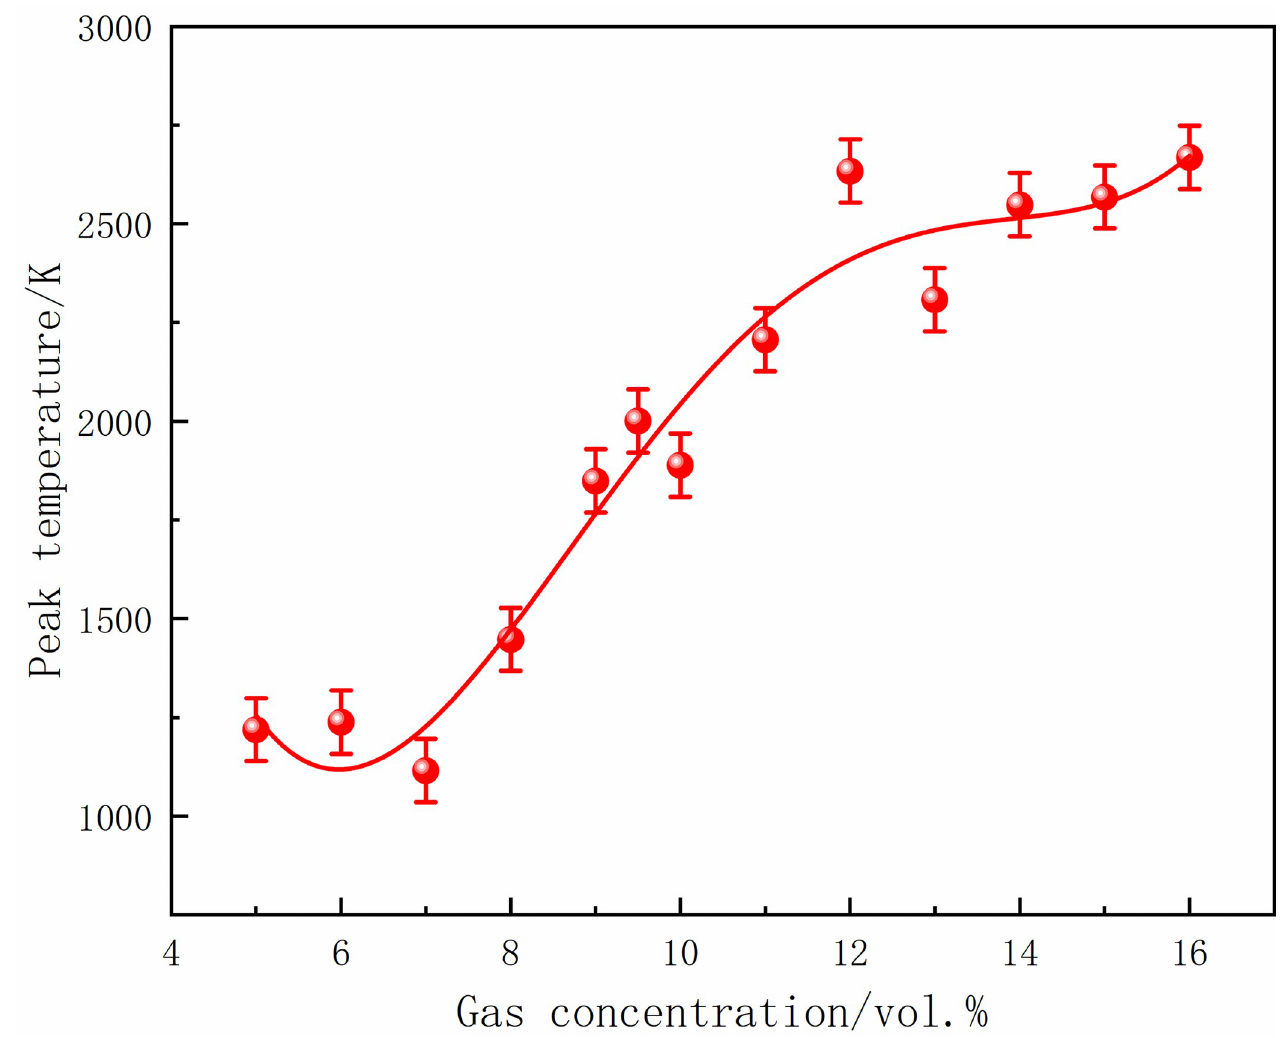
Fig 28. Temperature peaks at different local gas concentrations at the monitoring point